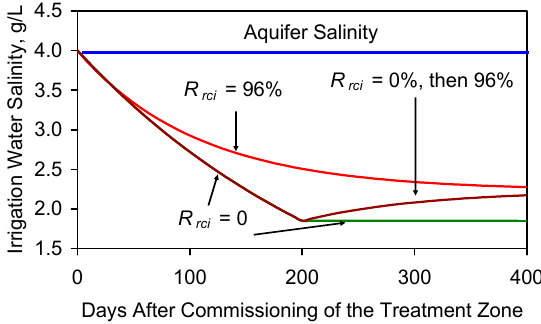
Figure F1. Change in salinity of the irrigation water abstracted from the modeled Aquifer Treatment Zone with time. Aquifer salinity = 4 g/L. Process Flow Diagram = Figure 20. R rci = Reinjection ratio = y /( y + m ). Water reinjected at the aquifers periphery. (i) = aquifer salinity = irrigation water salinity without the Aquifer Treatment Zone ; (ii) irrigation water salinity if R rci = 0; (iii) irrigation water salinity if R rci = 0 for 200 days, followed by R rci = 0.96 (96% of the abstracted water is reinjected); (iv) irrigation water salinity if R rci = 0.96. Aquifer Thickness = 1 m; Rate Constant = Figure B2b. Recycle ratio = 480/20 = 24; R rci = y /( y + m ), m = 20 m 3 · day − 1 , x = 20 m 3 day − 1 , y = 480 m 3 · day − 1 , n = 0 m 3 ·day − 1 (Figure 20).